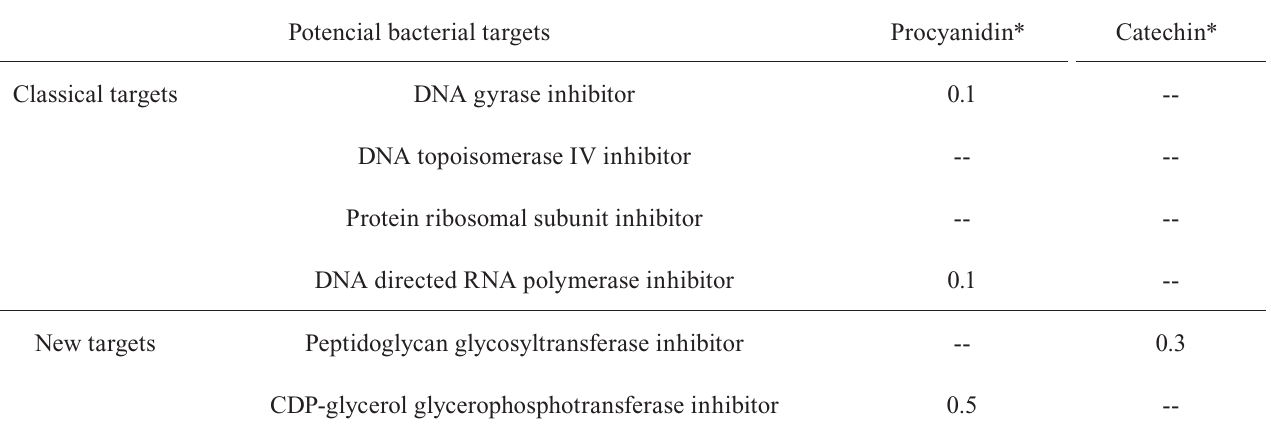
TABLE III - In silico test prediction of potential bacterial targets of procyanidin and catechin using PASSonline tool